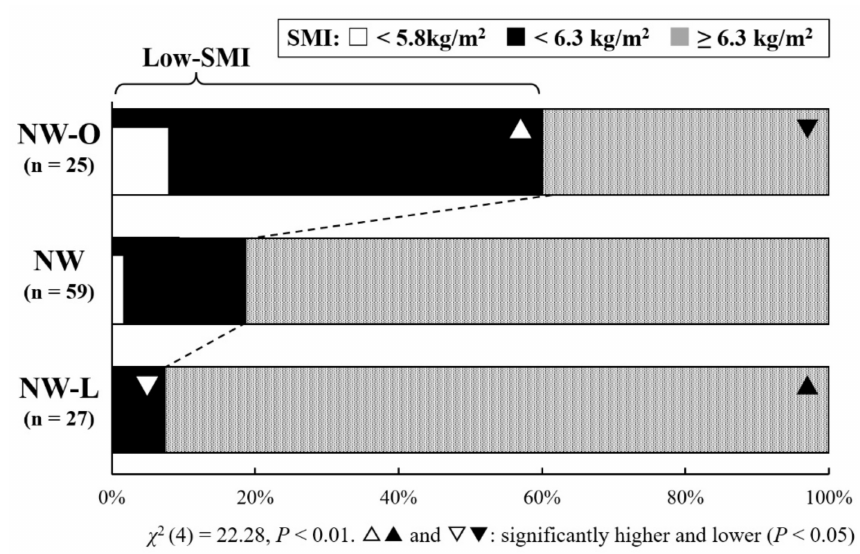
Figure 1. The proportion of Low-SMI in NW-L, NW, and